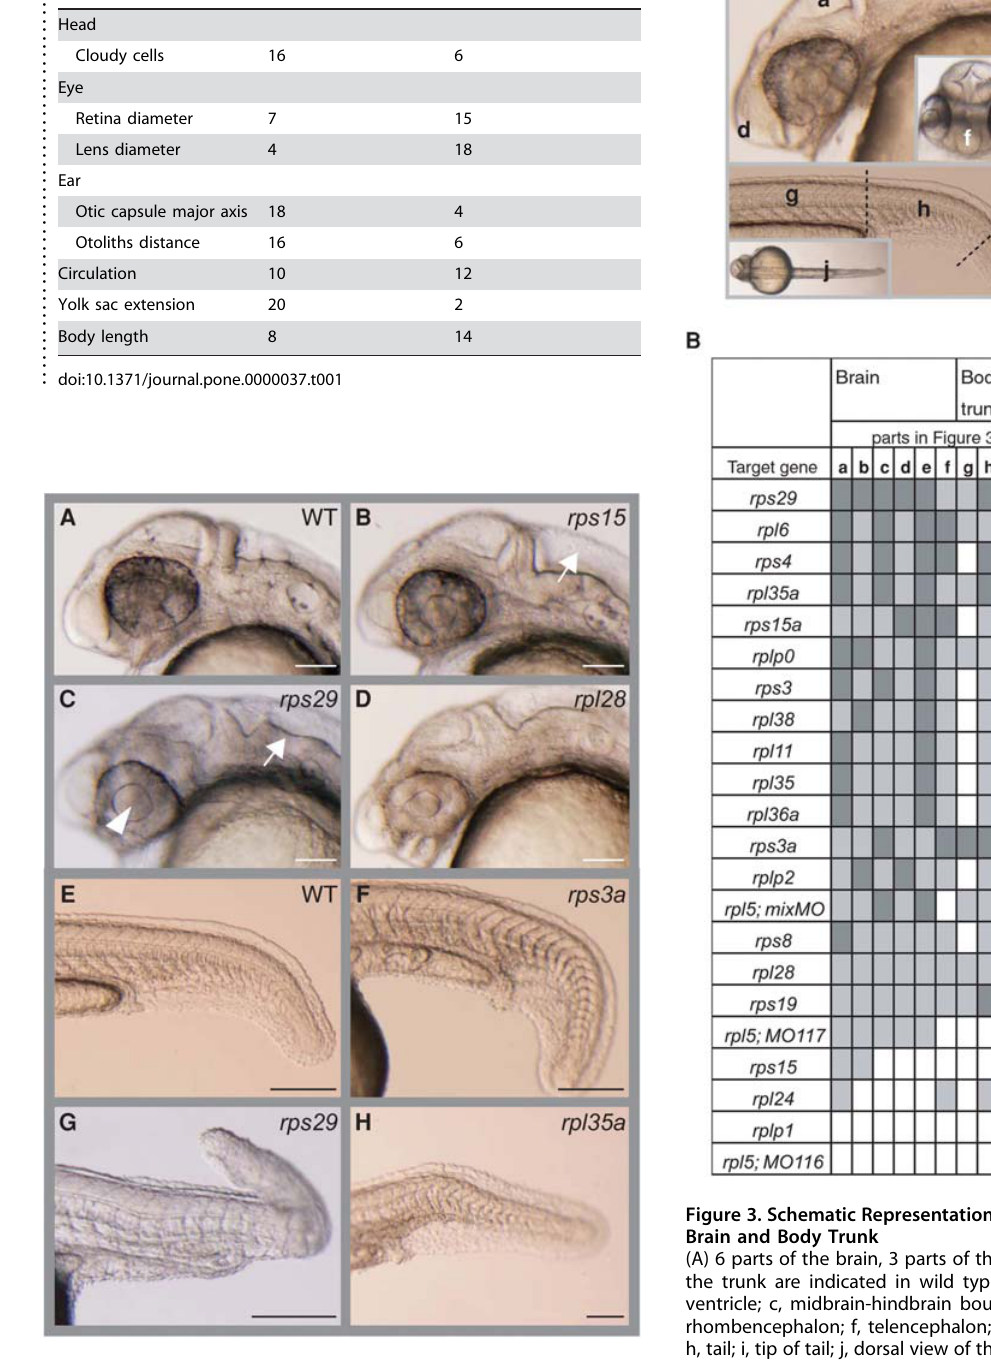
Figure 2. Specific Morphological Changes in Brain and Body Trunk Examples of morphants displaying characteristic deformations are shown. The targeted genes and the deformed areas of the morphants are indicated. (A, E) Wild type (WT). (B) rps15 ; enlarged 4th ventricle (white arrow). (C) rps29 ; enlarged lens (arrowhead) and undulated rhombencephalon (white arrow). (D) rpl28 ; protruded forehead. (F) rps3a ; wider trunk and downward-curving tail. (G) rps29 ; wavy notochord and extremely bent tail. (H) rpl35a ; sharply downward bent tail. Anterior is to the left. Bars: A , D, 100 m m; E , H, 200 m m.